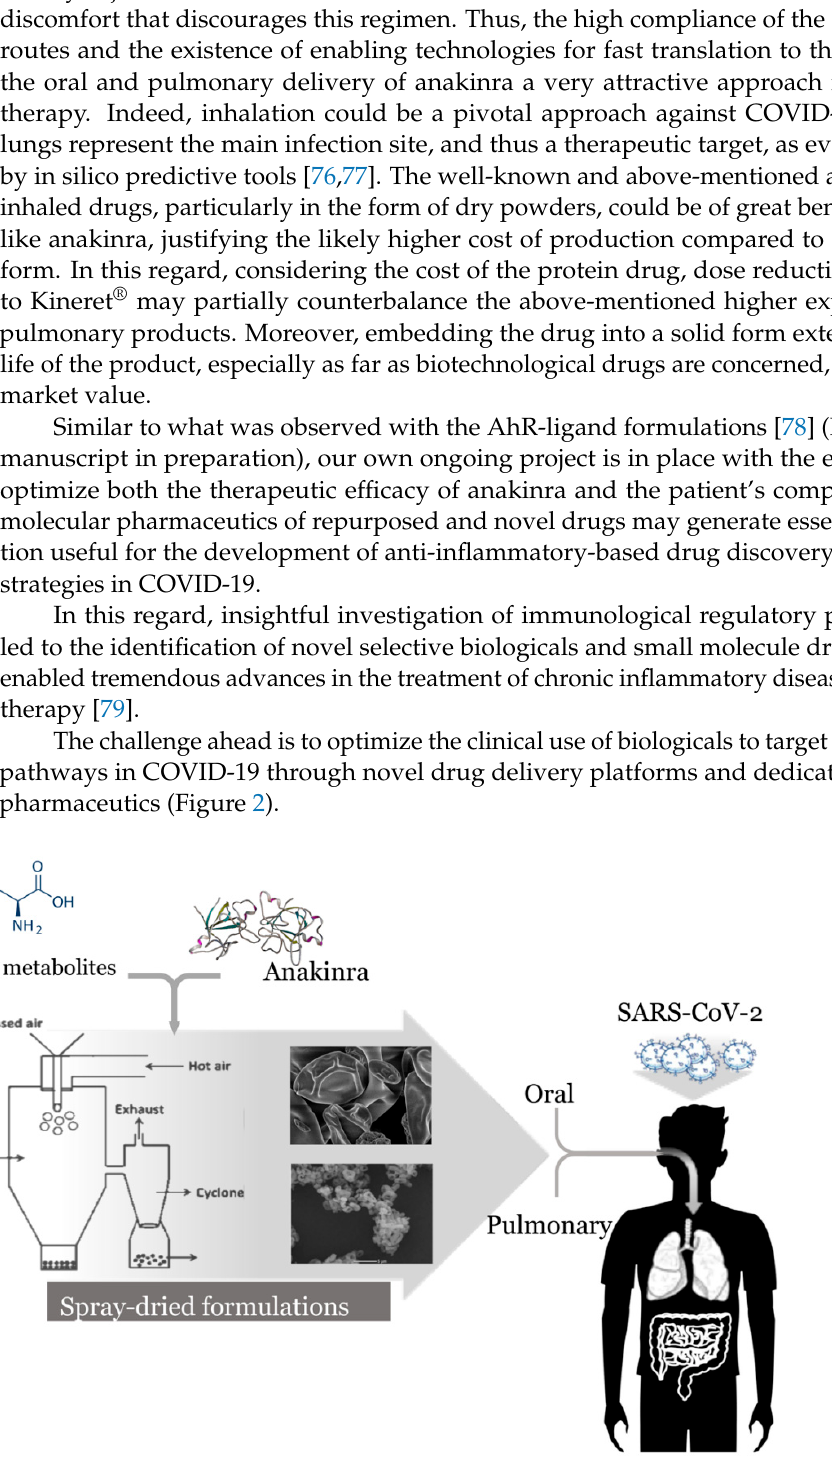
Figure 2. Molecular pharmaceutics of tryptophan metabolites and anakinra in the treatment of COVID-19. The pulmonary route is preferred for enhanced local effect and dose reduction. The oral route is also considered as an alternative, highly compliant and cost-effective